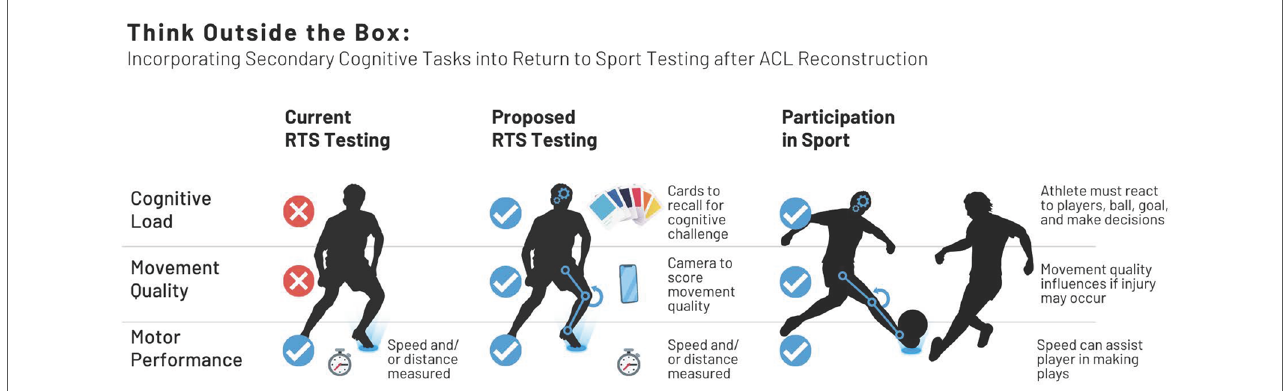
FIGURE 1 A graphical abstract of current return to sport (RTS) testing, proposed RTS testing, and participant in sport with regard to cognitive load, movement quality, and motor